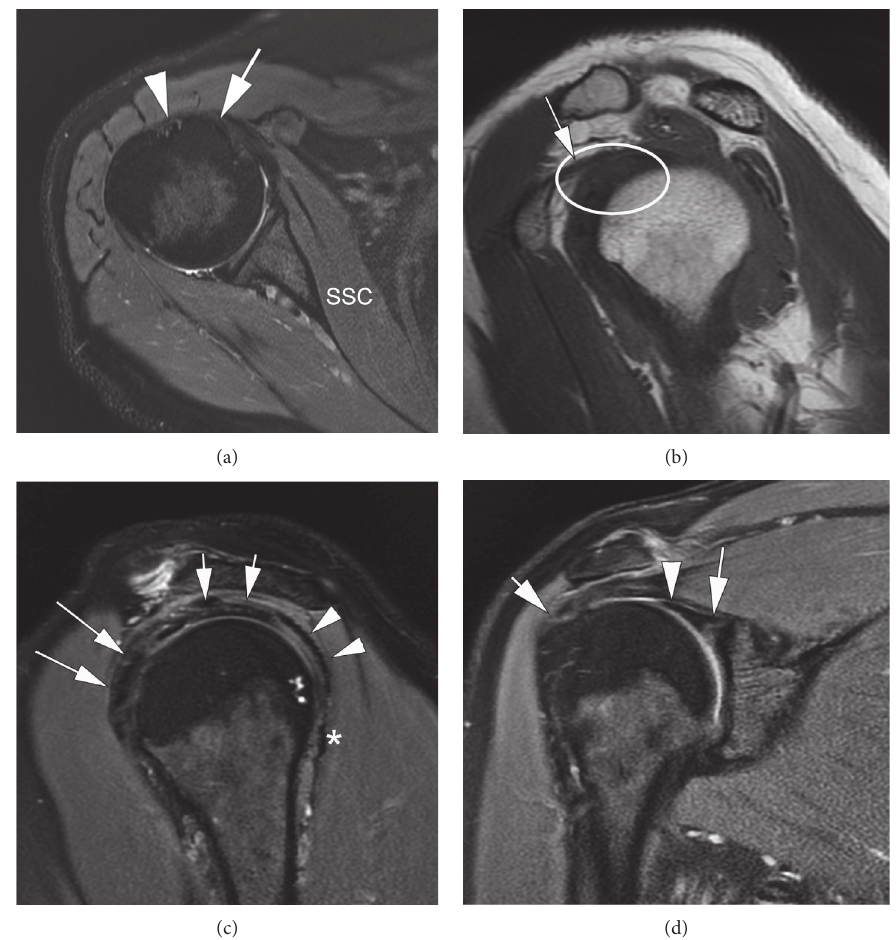
Figure 3: Normal MRI of the right shoulder. Axial T2-weighted fat-suppressed (FS) MRI (a) demonstrates the subscapularis muscle (SSC) traversing along the anterior aspect of the scapula to insert on the lesser tuberosity of the humerus (arrow). The long head of the biceps tendon (arrowhead) is correctly positioned in the bicipital groove at this level. Sagittal oblique T1-weighed MRI (b) provides a view of the rotator interval (ellipse) with visualization of the coracohumeral ligament (arrow). Sagittal oblique T2-weighed FS MRI (c) shows the lateral subscapularis (long arrows), supraspinatus (short arrows), infraspinatus (arrowheads), and teres minor (star) tendons close to their humeral attachment. Coronal T2-weighted FS MRI (d) shows the biceps anchor (arrow head) and the proximal horizontal portion of the long head of the biceps tendon close to its attachment at the glenoid (long arrow). Note. Tendinosis of the supraspinatus attachment is reflected as intratendinous hyperintensity (short